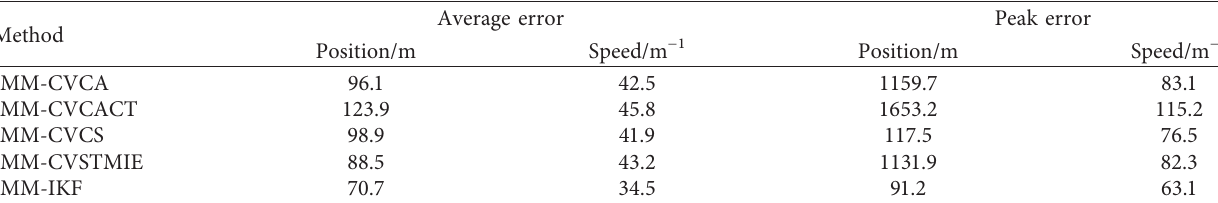
Figure 9: Root mean square error curve of position and velocity. (a) Root mean square error of position. (b) Root mean square error of speed. Table 1: Comparison of tracking performance of each